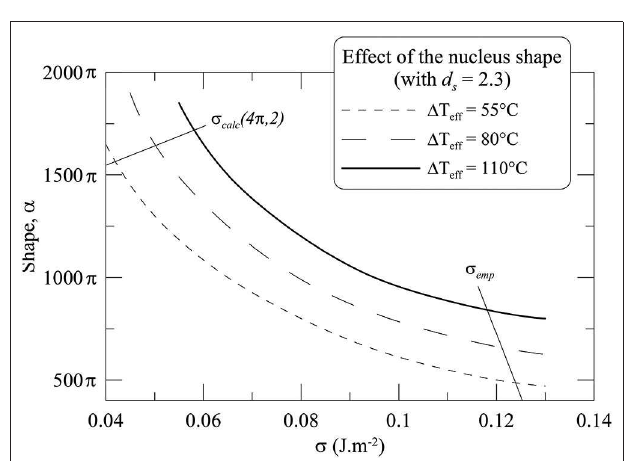
FIGURE 5 | Dependence of the interfacial energy ( σ ) on the nucleus shape ( α ) for a roughness d s of 2.3 (An 30 plagioclase), as a function of effective undercooling ( 1 T eff ). σ calc(4 π ; 2) and σ emp (as determined in Table 4 ) define a range of σ bracketed between microscopic and macroscopic values,